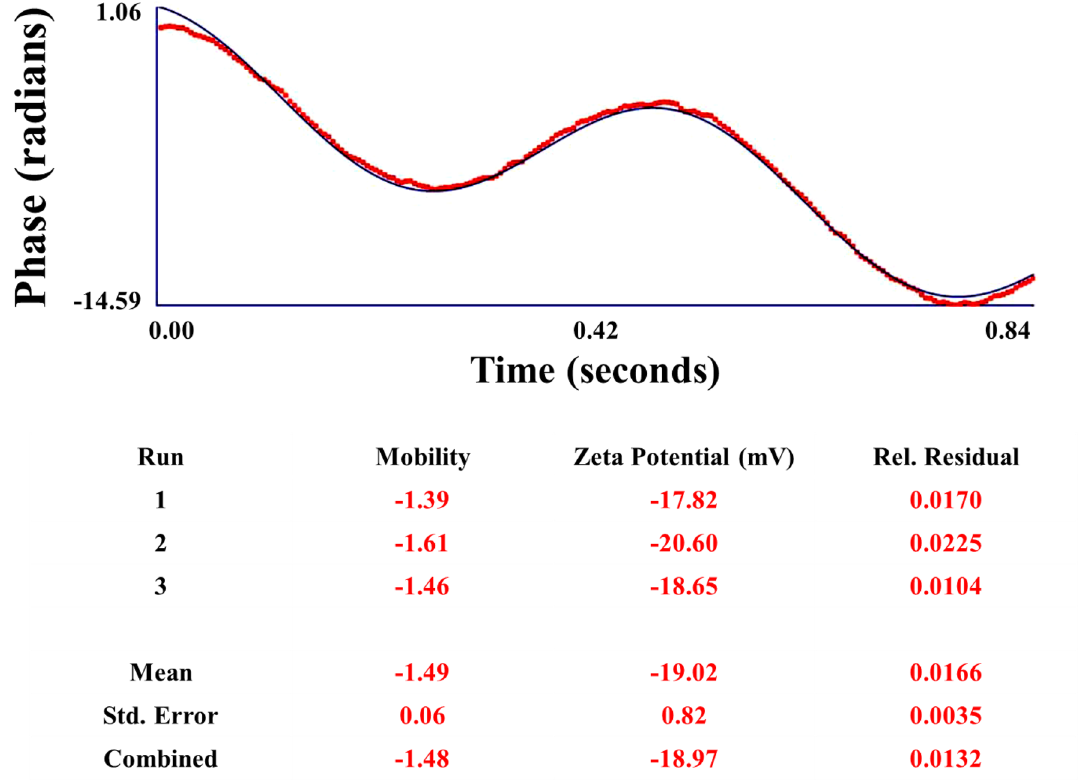
Figure 10. Zeta potential of Ag nanoparticle.